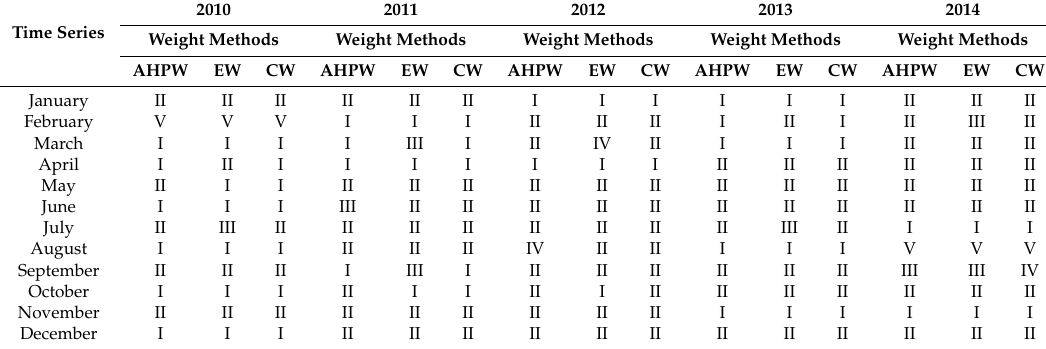
Table 5. Comparison of water quality grades based on game theory-based cloud model using various weights.